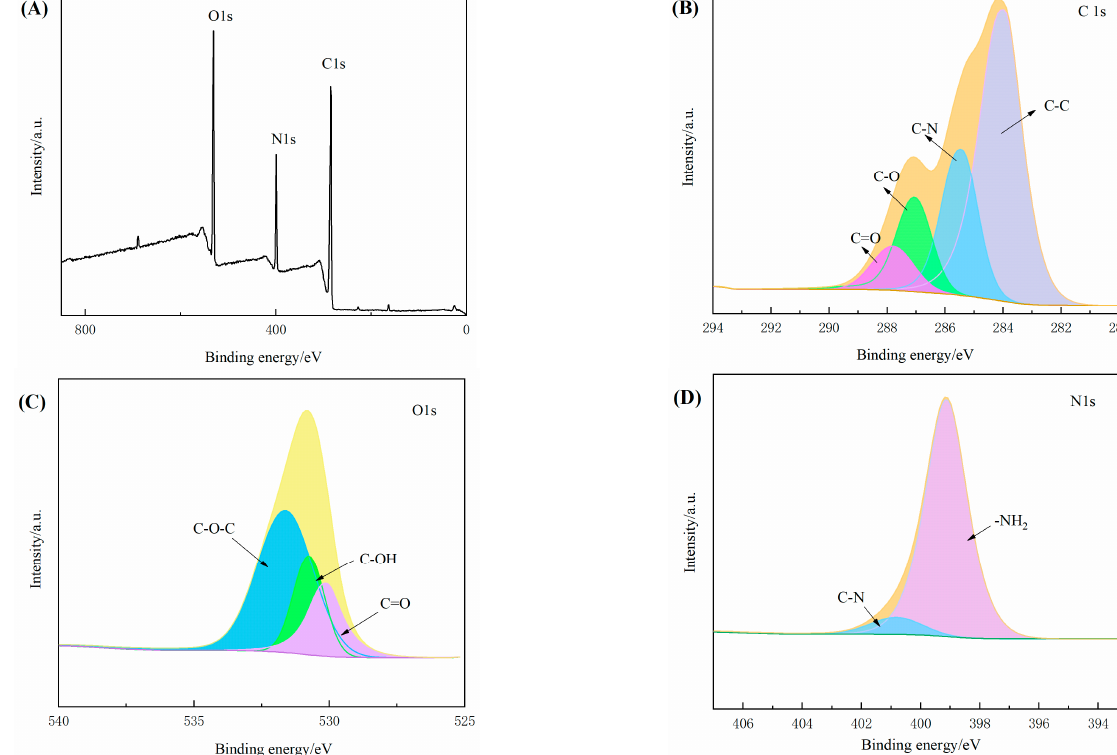
Figure 4. XPS survey spectra of ( A ) 3D–rGO–CS–BSA, ( B ) C 1s, ( C ) O 1s, and ( D ) N